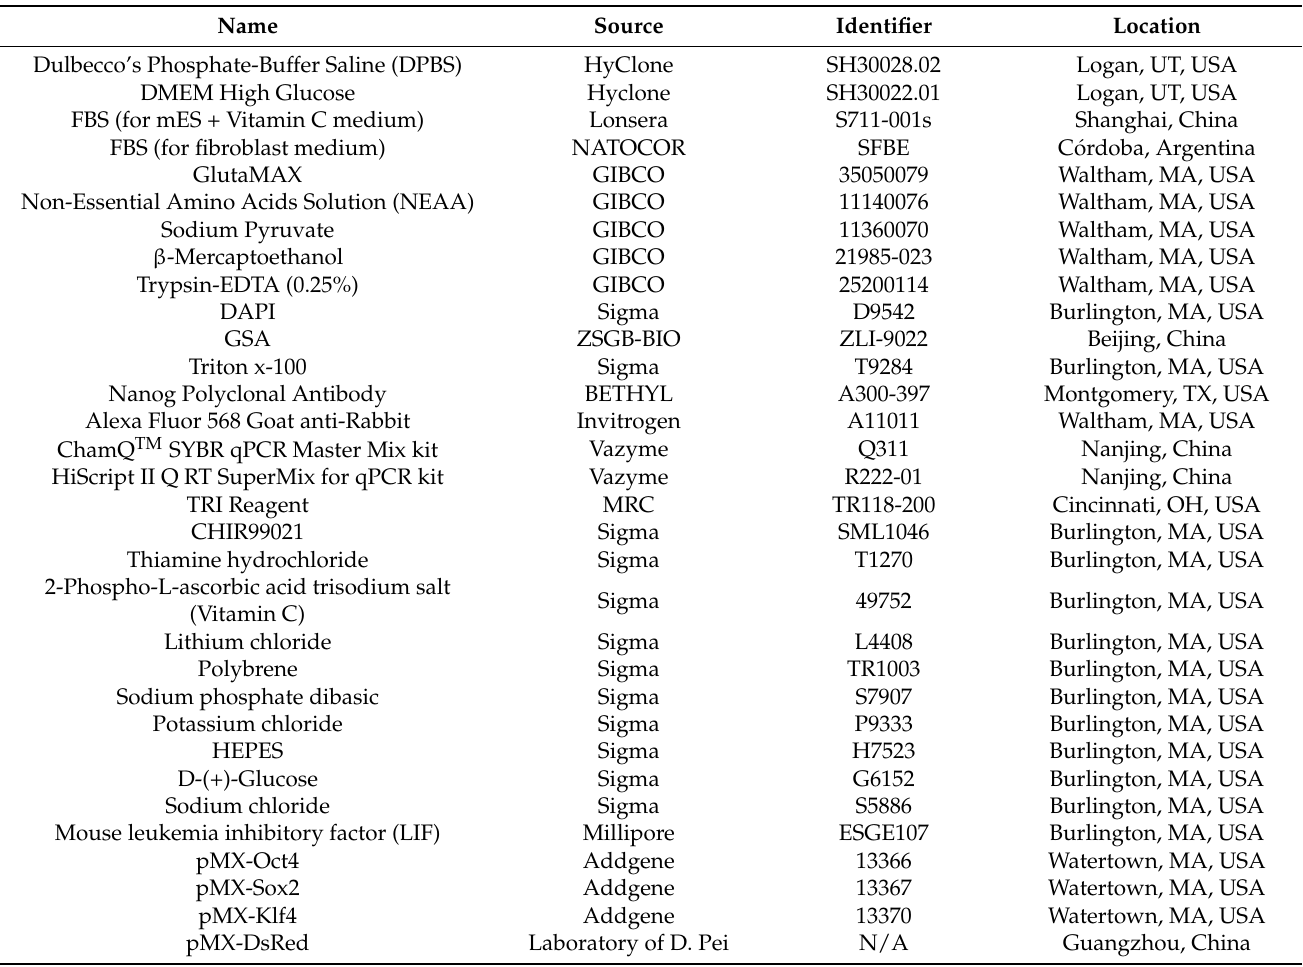
Table 2. Information on all chemicals, antibodies, recombinant proteins, and